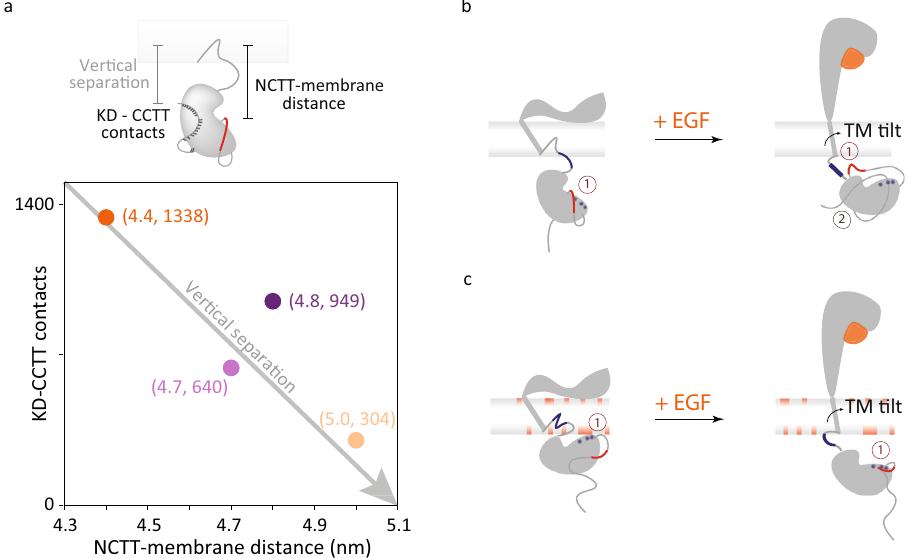
Fig. 4 Intracellular conformational changes upon extracellular EGF binding. a The intracellular conformation can be characterized by the distance between the NCTT and the membrane and the contacts between the CCTT and the KD. The positions of WT EGFR in both neutral (dark colors) and partially anionic (light colors) lipid bilayers in the absence (purple) and presence (orange) of EGF are plotted as a function of the average NCTT-membrane distance and KD-CCTT contacts obtained from simulations. The average vertical separation between the center of mass of the membrane and residue 1186 from simulations is used to compare with the smFRET measurement. b , c Schematic of proposed mechanism for EGFR (gray) conformational changes upon EGF (orange) binding in b neutral and c partially anionic membrane. Numbers indicate electrostatic (dark red) and hydrophobic (dark green) interactions. b Left: the fl at extracellular domain tilts the transmembrane helix, pulling the JMD (blue line) into the lipid bilayer. The negatively charged NCTT (red) interacts with the positive residues in the KD (blue) leading to the release of the CCTT. Right: with EGF bound, the upright extracellular domain allows the transmembrane helix to be vertical, causing the full JMD to protrude from the membrane. The positively-charged JMD (blue) attracts (1) the negatively- charged CTT (red). In combination with hydrophobic interactions between the CCTT and KD (2), the attraction produces an intracellular compaction. c Left: the transmembrane tilt and the anionic lipids embed the positively-charged JMD into the membrane, which pulls the positively-charged KD (blue) closer to (1) interact with the negatively-charged lipids (red). Right: with EGF bound, the upright transmembrane domain extends the JMD out of the membrane, further positioning the KD away from the membrane. The positive residues in the KD (blue) interact (1) with the negatively-charged CTT